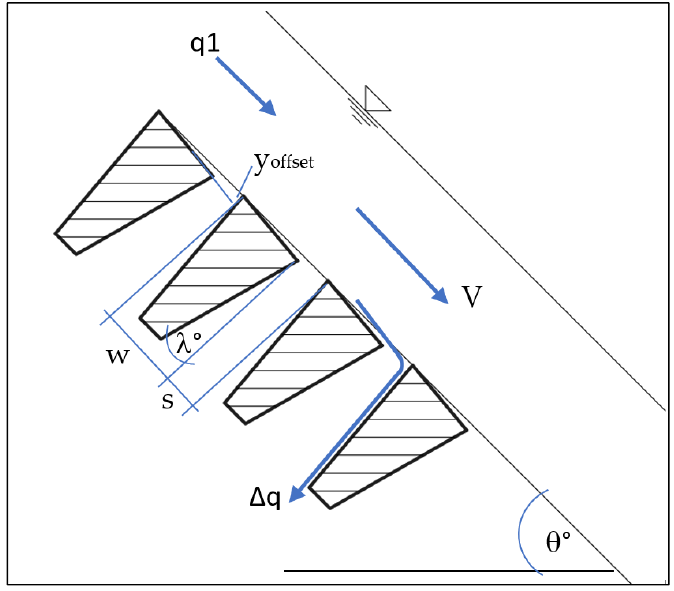
Figure 1. Detail of screen geometry and key variables. (Adapted from [4]).